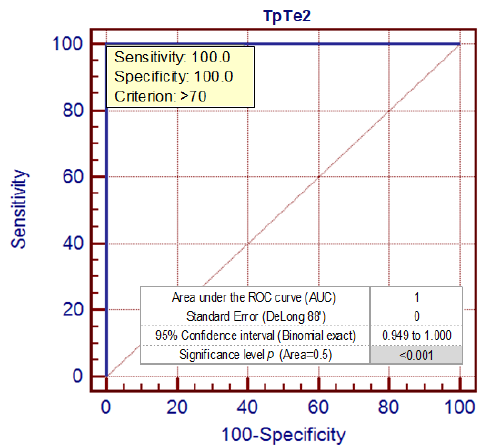
Figure 5. The ROC curve (AUC) analysis for TpTe intervals [ms] in a syncopal group and control group in the upright phase during the HUTT—Phase 2 (TpTe2).